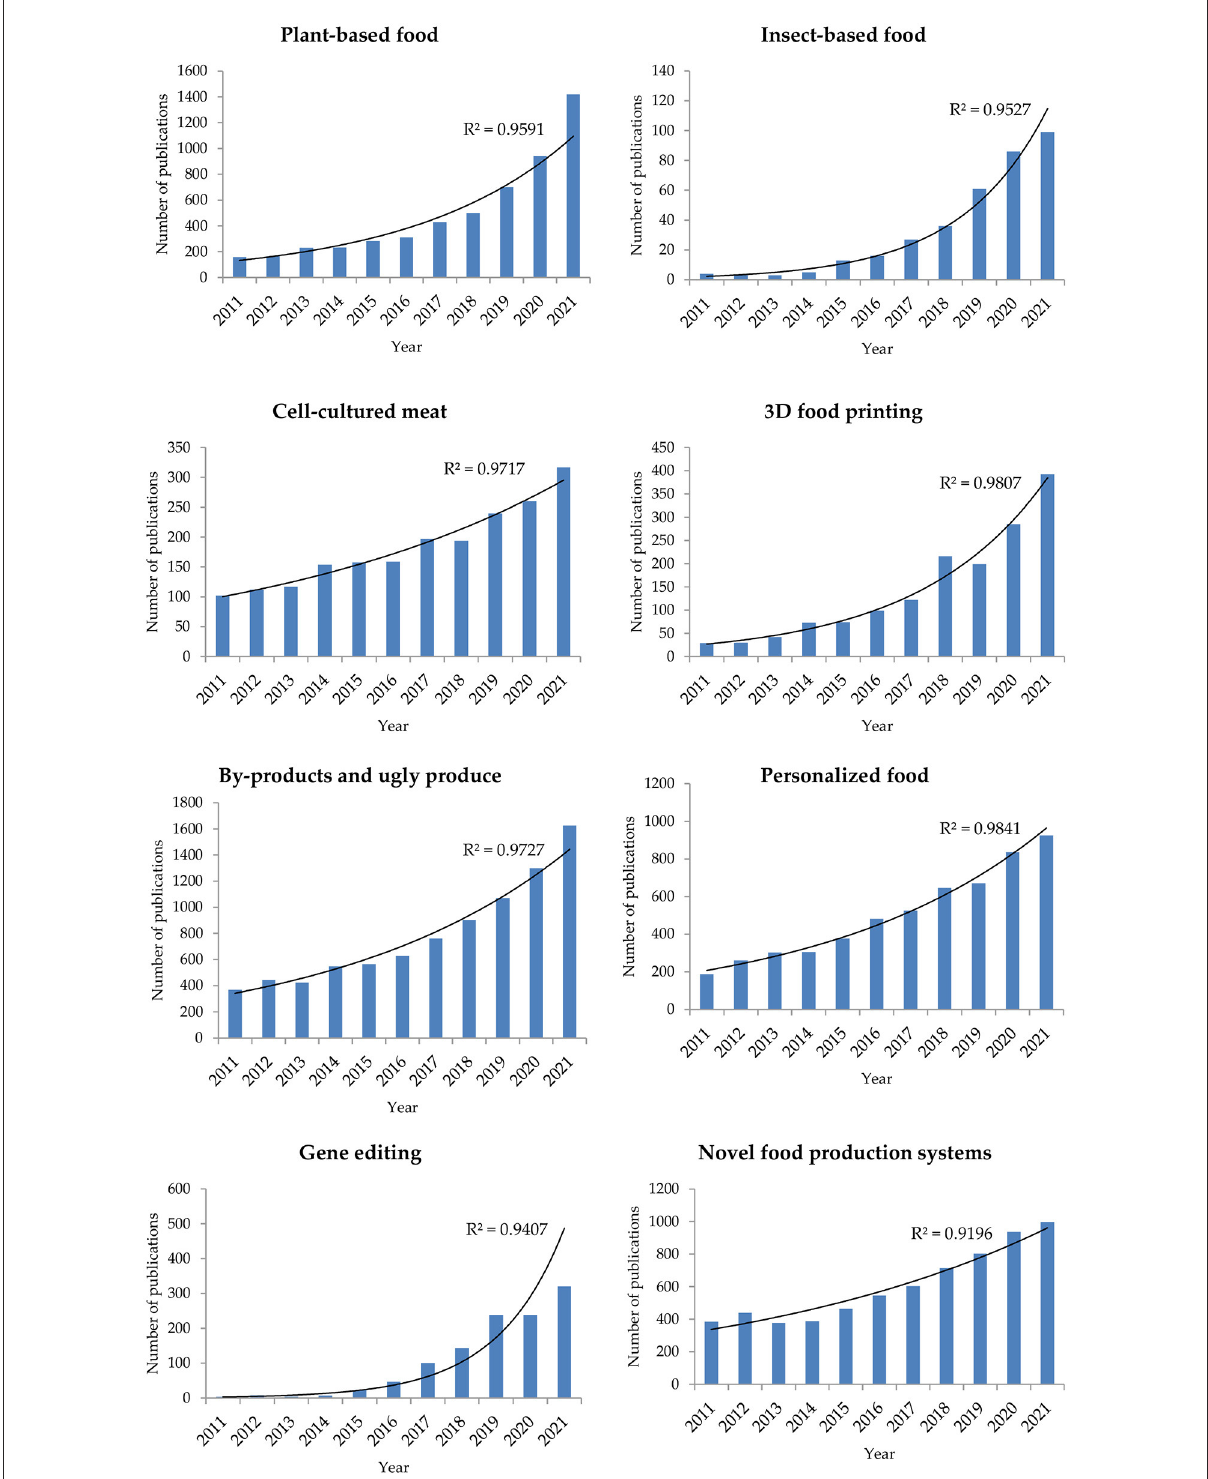
FIGURE2 Number of publications per year (until March 2022) dealing with emerging food trends (data obtained from